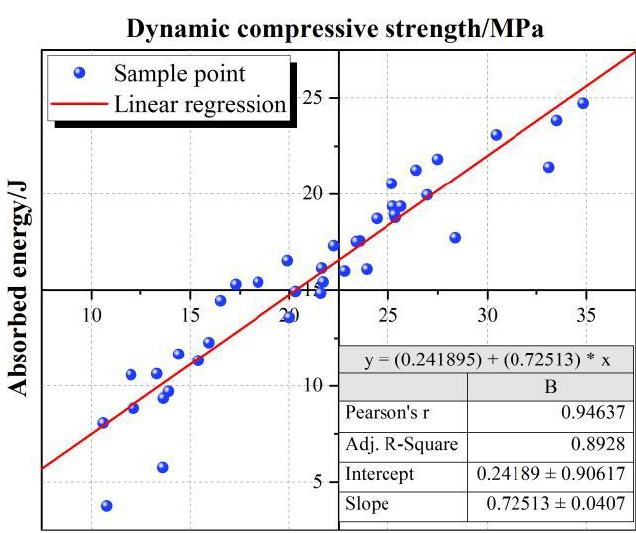
Figure 3. Linear fitting of Ep and dynamic compressive strength of RASM.